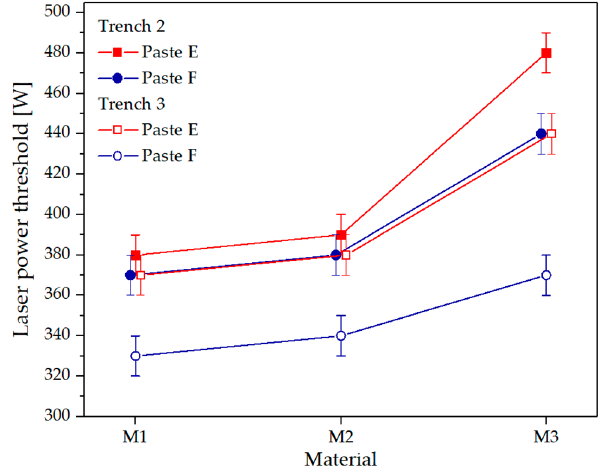
Figure 5. Nominal laser power threshold required to release pastes E and F from different film materials with trenches 2 (closed symbols) and 3 (open symbols).